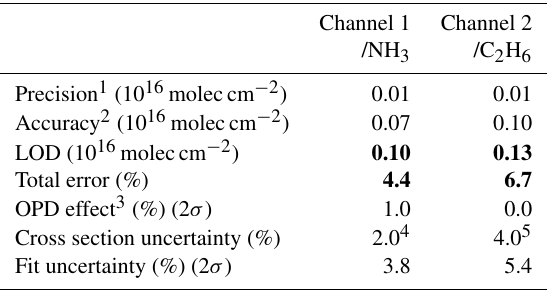
Table 4. Results of the FTS quality assurance.